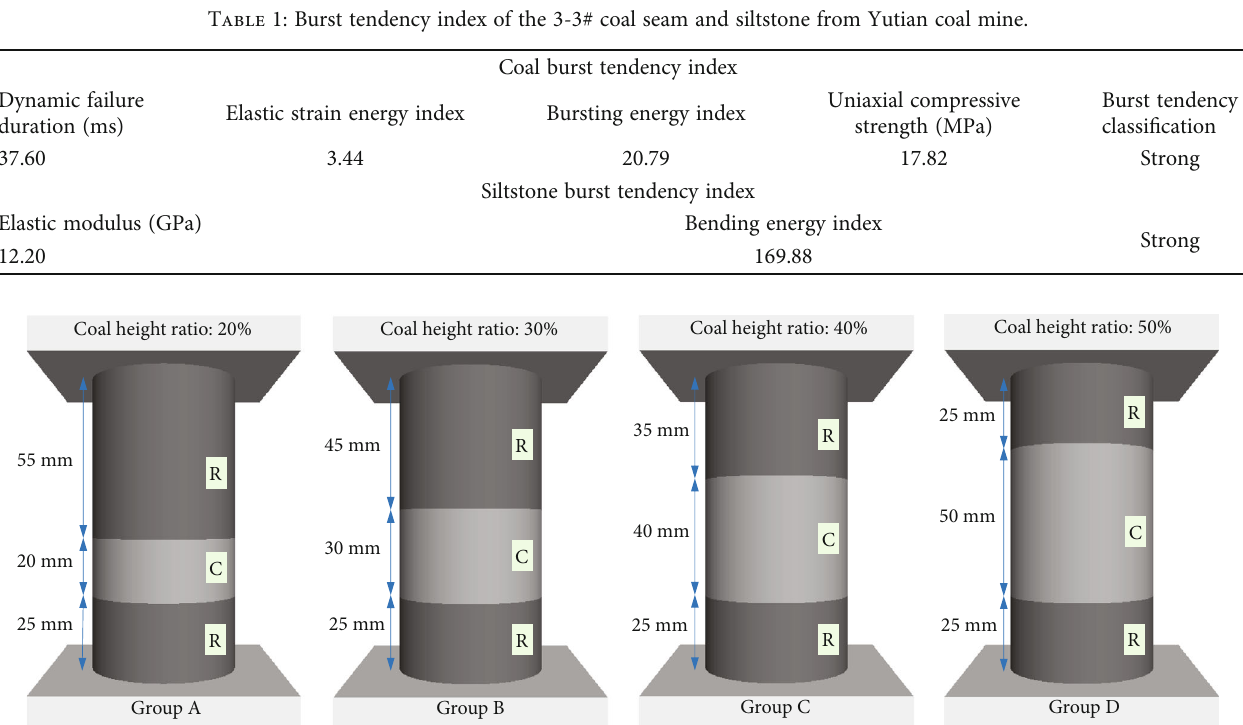
Figure 1: Sketch map of rock-coal-rock combined